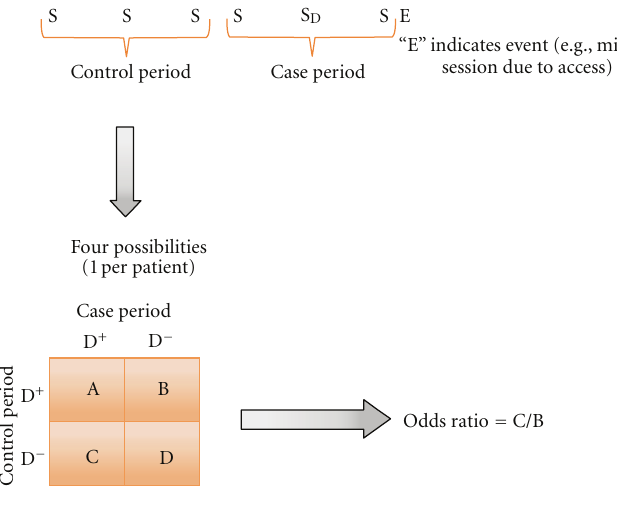
Figure 2: Case-crossover